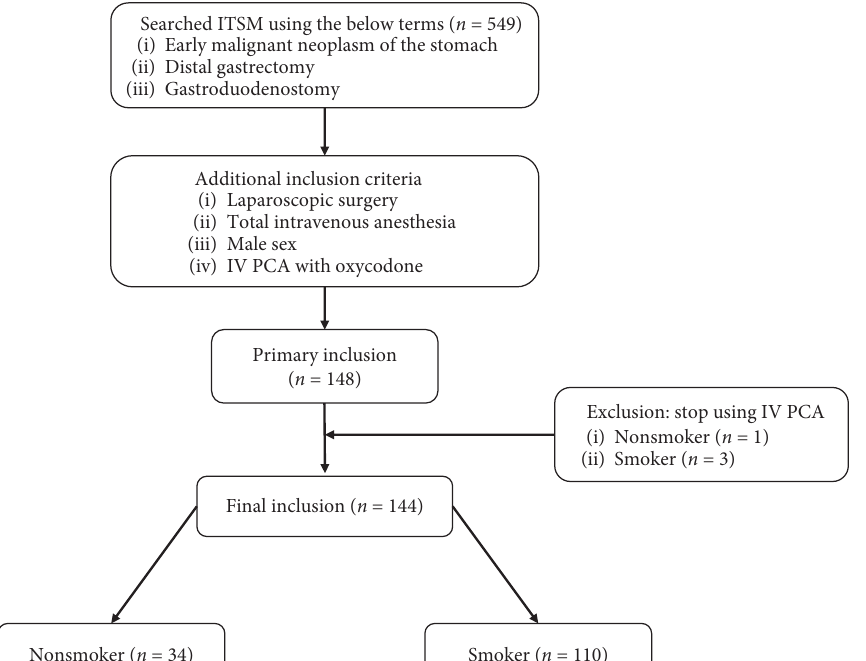
Figure 1: Flowchart of the present study. ITSM: Information Technology of Service Management; IV PCA: intravenous patient-controlled